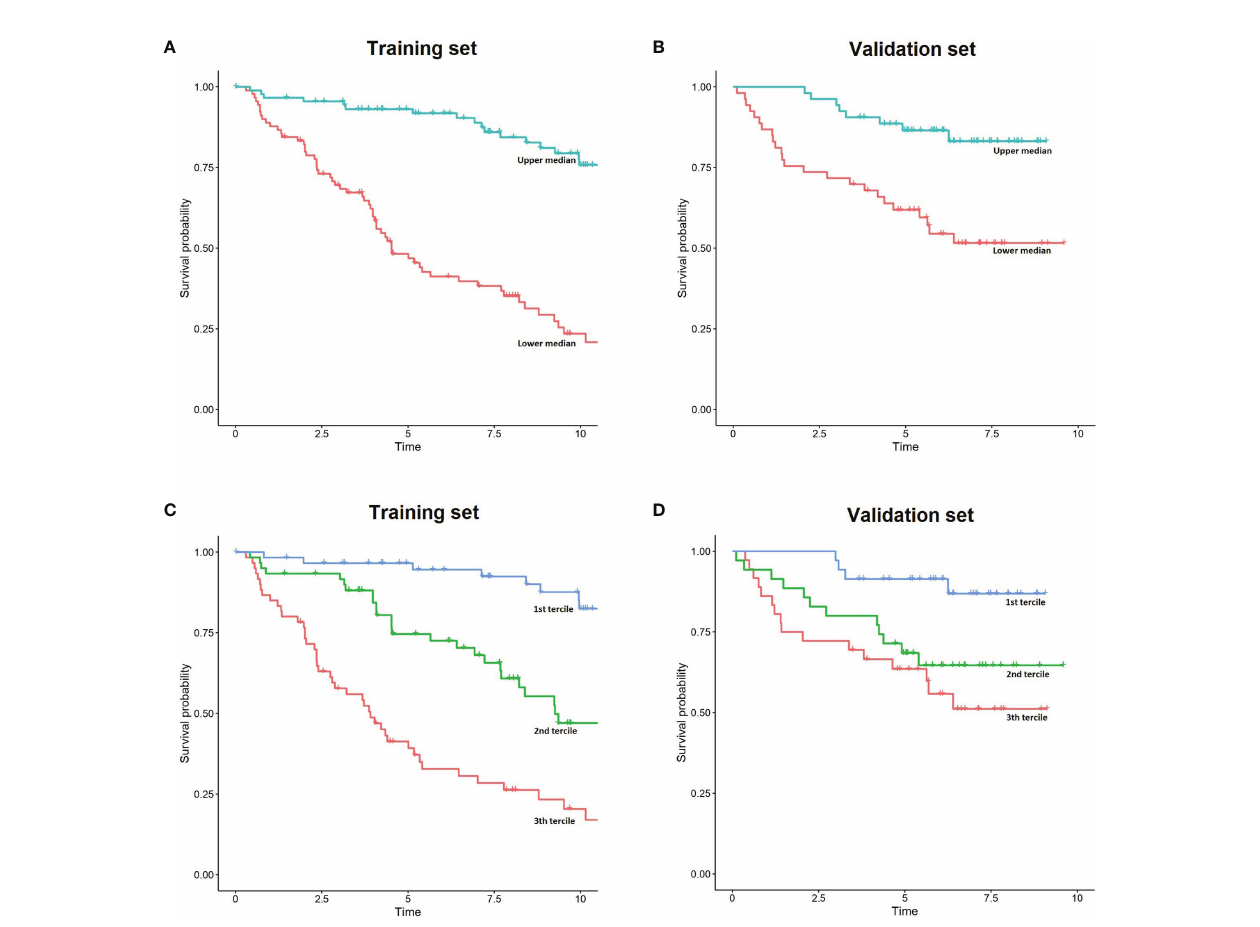
FIGURE 2 | Simpli fi ed representation of IAC-FL predictions. (A, B) FL patient outcome according to the predicted 5-year survival medains created by IAC-FL in both the training and test sets. (C, D) Survival outcomes according to the predicted 5-year survival terciles created by IAC-FL in the training and test sets,